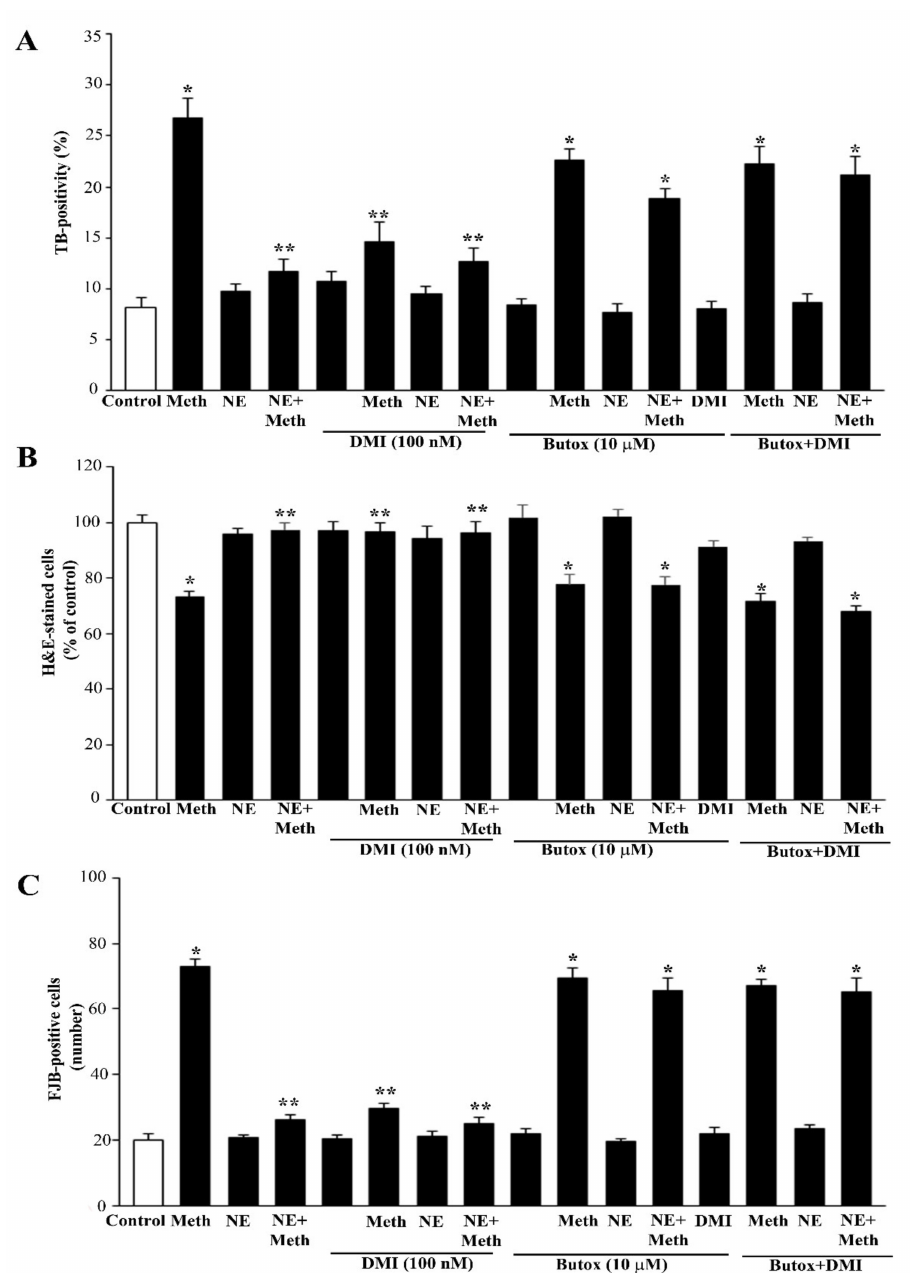
Figure 7. Protection of the NET blocker DMI on Meth toxicity through β 2-AR is reverted by butox- amine. When the blocker of the NE transporter (NET) desmethylimipramine (DMI) was administered at the dose of 100 nM to PC12 cells, no effect could be detected. However, DMI 100 nM markedly protects against toxicity induced by Meth 50 µ M to an amount that was comparable to NE 5 nM.